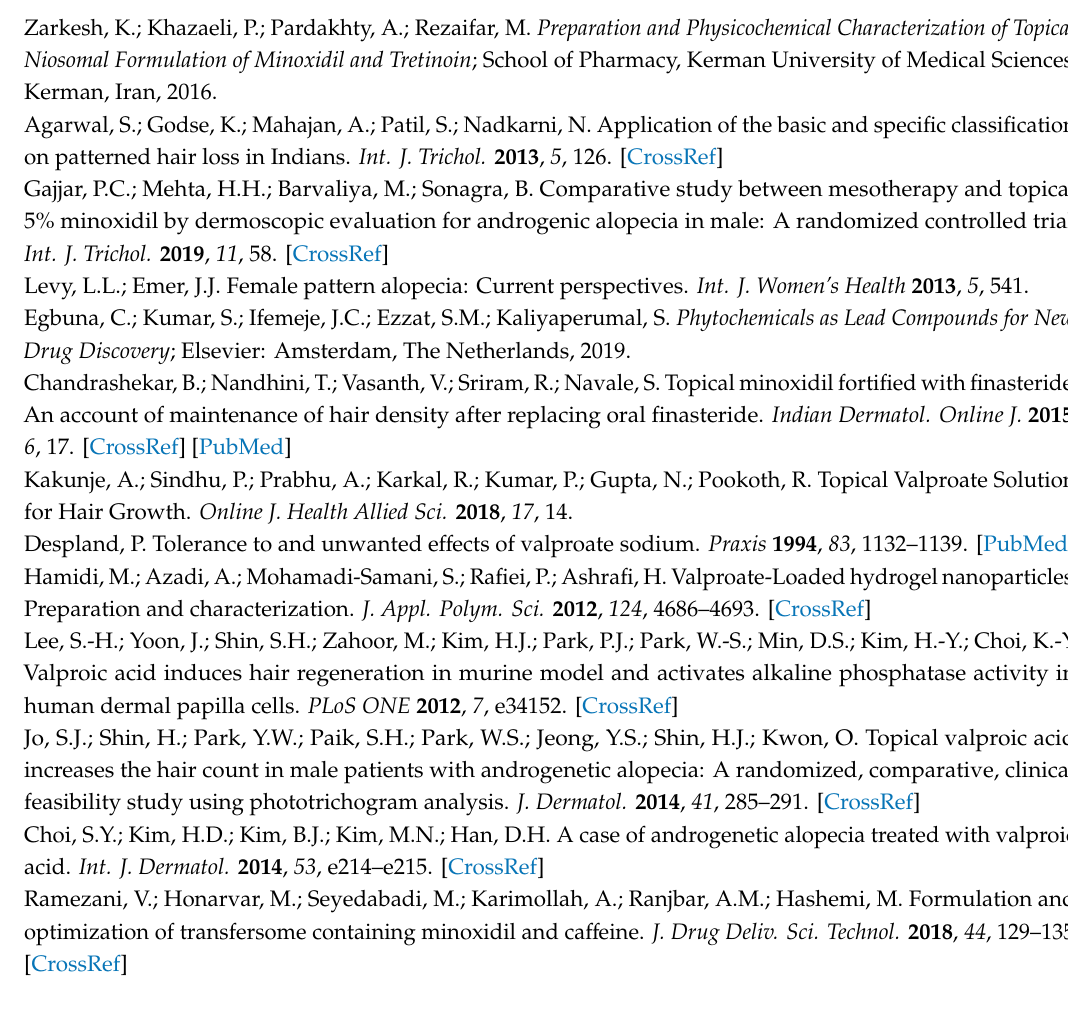
Table S1: Prescreening study for formulation of SV-loaded SNVs, Table S2: Determination of the elasticity of SV-loaded SNVs and the corresponding niosomes, Table S3: The correlation between the hair follicles number / cm 2 in the studied groups, Table S4: The correlation between the hair shaft diameter ( µ m) in the studied groups, Table S5: The correlation between the hair density / cm 2 in the studied groups, Table S6: Side e ff ects among the studied groups, Figure S1: HPLC chromatogram of